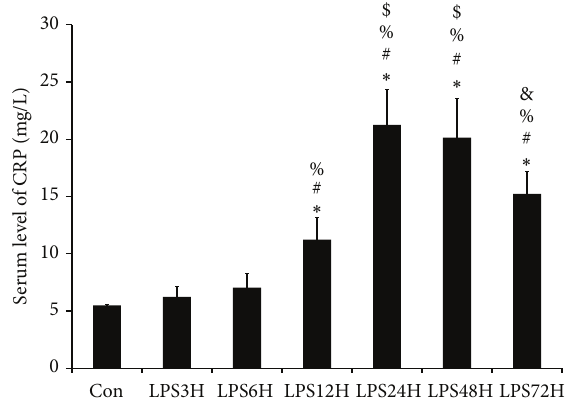
Figure 4: Serum CRPlevel in mice after experimental endotoxemia. It was observed that this inflammatory marker increased signifi- cantly at 12 to 24 hours after LPS treatment and remained high till 48 hours, indicating the onset of inflammation and the level began to decrease gradually after 72 hours. The following symbols represent the significant change between: ∗ control serum versus LPS treated serum, # LPS treatment for 3 hours versus LPS treatment for 6, 12, 24, 48, and 72 hours, % LPS treatment for 6 hours versus LPS treatment for 12, 24, 48, and 72 hours, $ LPS treatment for 12 hours versus LPS treatment for 24, 48, and 72 hours, & LPS treated for 24 hours versus LPS treated for 48 and 72 hours. Significant change ( 𝑃 < 0.05 ). Con- control serum, LPS3H- LPS treated for 3 hours, LPS6H-LPS treated for 6 hours, LPS12H-LPS treated for 12 hours, LPS24H- LPS treated for 24 hours, LPS48H- LPS treated for 48 hours, and LPS72H-LPS treated for 72